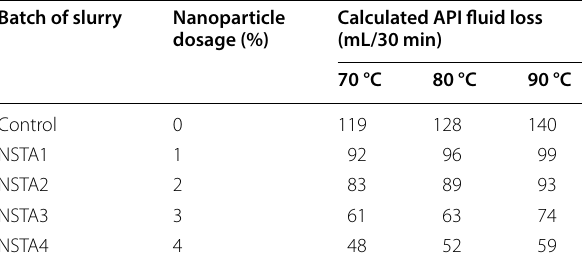
Table 3 The effect of adding ternary nanoparticles on fluid loss